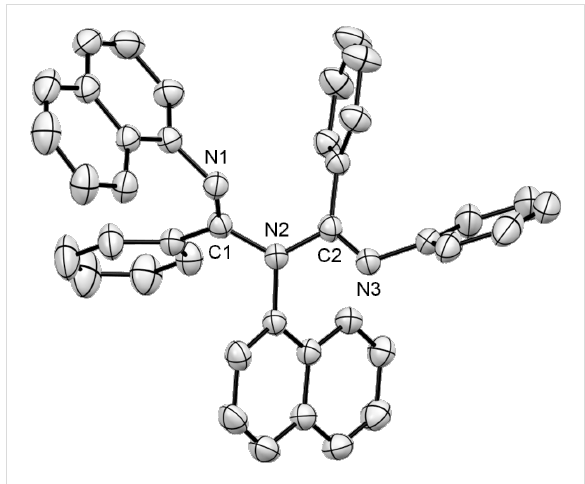
Figure 4: ORTEP drawing of 3c . Thermal ellipsoids are set at 35% probability level. Hydrogen atoms are omitted for clarity. Selected bond lengths [Å] and angles [°] are as follows: C(1)–N(1) 1.269(3), C(1)–N(2) 1.413(3), C(2)–N(2) 1.411(3), C(2)–N(3) 1.274(3), N(1)–C(1)–N(2) 116.5(2), C(1)–N(2)–C(2) 119.1(2), N(2)–C(2)–N(3)